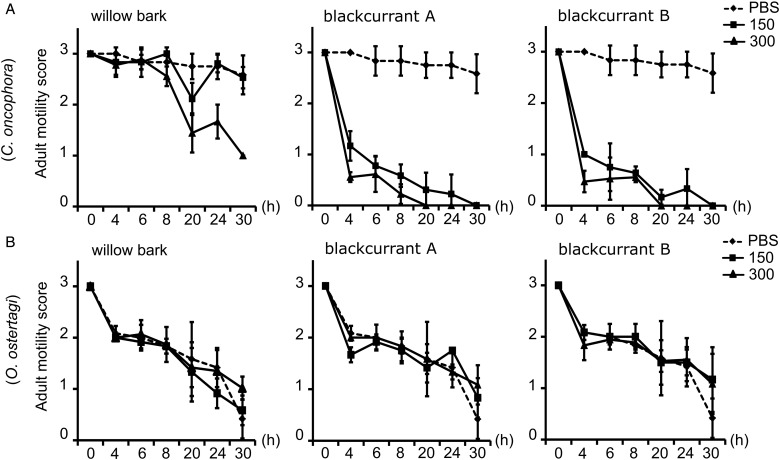
Results on the motility of adult worms of Cooperia oncophora in row (A) and Ostertagia ostertagi in row (B), incubated in triplicates either in control media (PBS) or CT fractions of willow bark or blackcurrant leaves at 150 and 300 µg mL−1. The motility was assessed within 10 s by observation using a scaled score 0–3: with 3 (active movement), 2 (slow movement), 1 (only moving one part of the body) and 0 (no movement). At each time point the average motility score of the triplicates was plotted with error bars showing the s.d.